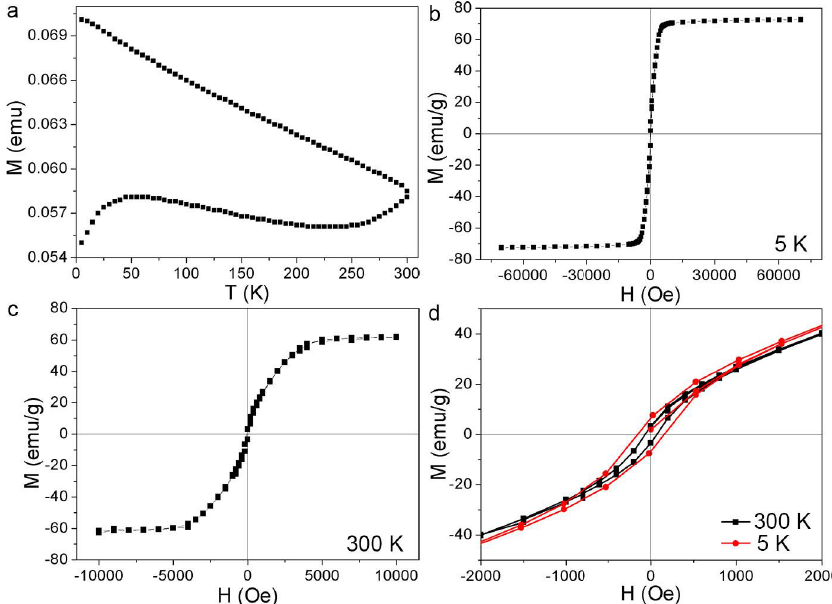
Figure 8. Magnetic characterization of the Fe@ α -Fe 2 O 3 particles synthesized by laser ablation in acetone. ( a ) ZFC/FC curves in 50 Oe, ( b , c ) hysteresis curves at 5 and 300 K. ( d ) Magnified hysteresis curves at 5 and 300 K.